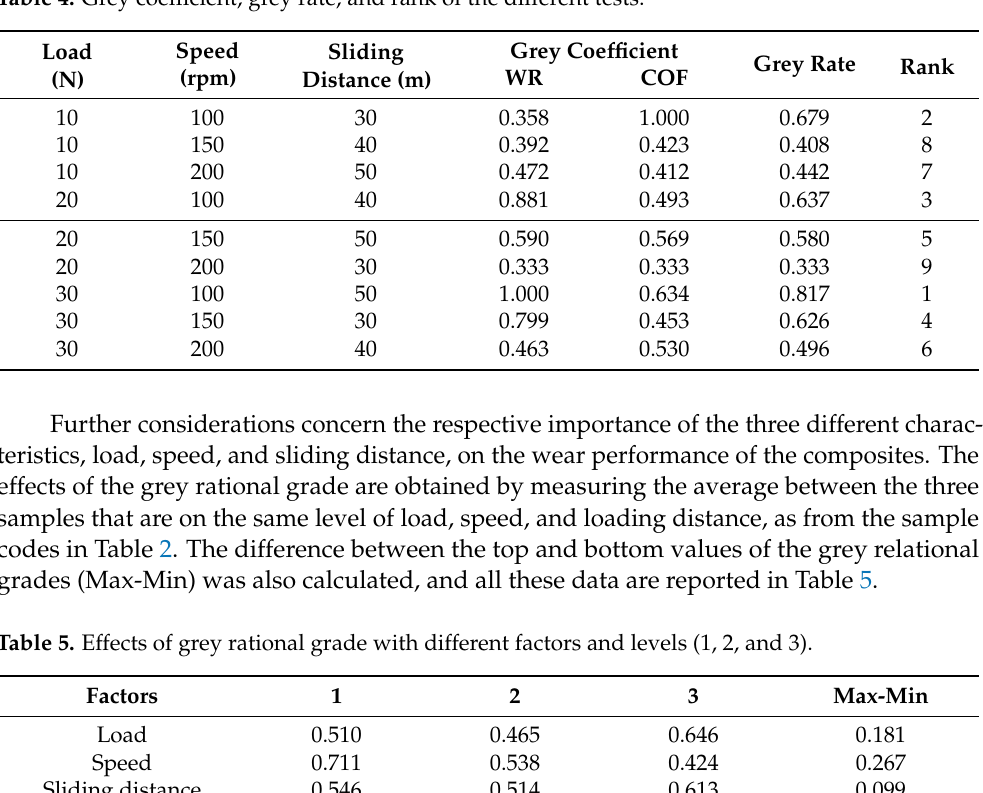
Table 4. Grey coefficient, grey rate, and rank of the different tests.